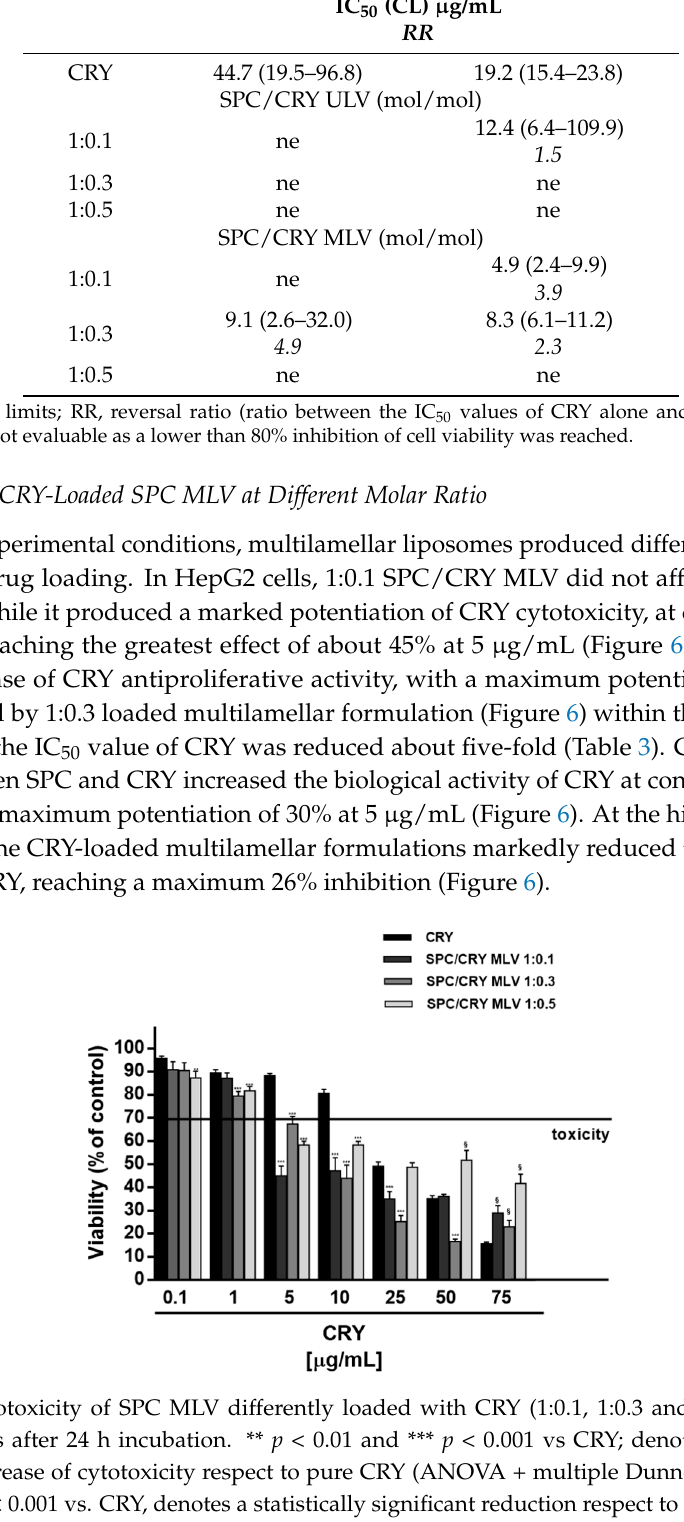
Figure 7. Cytotoxicity of SPC MLV differently loaded with CRY (1:0.1, 1:0.3 and 1:0.5 mol/mol) in MDA-MB-468 cells after 24 h incubation. ** p < 0.01 and *** p < 0.001 vs. CRY, denotes a statistically significant increase of cytotoxicity respect to pure CRY (ANOVA + multiple Dunnett’s comparison post-test). § p < 0.001 vs. CRY, denotes a statistically significant reduction respect to CRY cytotoxicity (ANOVA + multiple Dunnett’s comparison post-test). A cell viability lower than 70% respect to control (i.e., vehicle-treated cells) was considered as cytotoxic [26]. 3.5. Evaluation of the Potential Interaction between CRY and SPC ULV In order to better characterize the possible interaction between CRY and SPC ULV, additional experiments in which the two separate components were co-administered to cells, at the same concentrations found in liposome formulations, were performed in HepG2 cells. When administered in the presence of SPC ULV, CRY exhibited a lower cytotoxic behaviour with respect to the pure compound. Despite a biologically relevant toxicity of the pure compound alone, the presence of SPC ULV induced a significant loss of CRY bioactivity. About a 30% reduction of its antiproliferative effect is observed (Figure 8) probably due to the high hydrophobic nature of CRY, which is therefore carried off by liposomes.